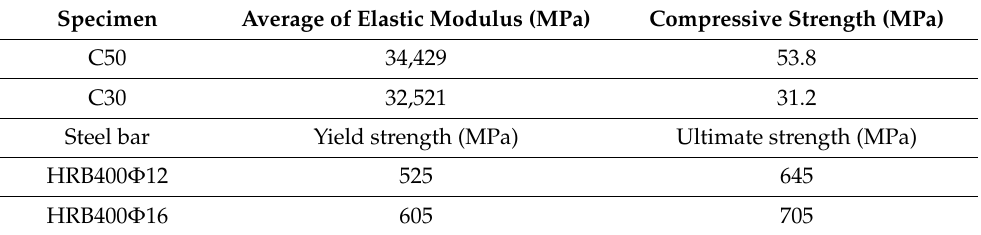
Table 2. Material test results of concrete and steel bar.